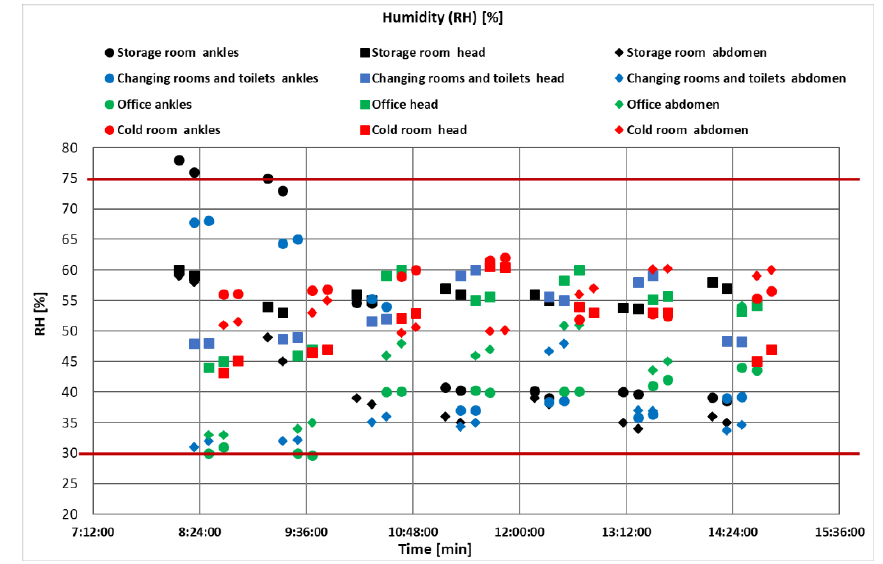
Figure 5. The course of humidity at different height levels in the objectified locations.